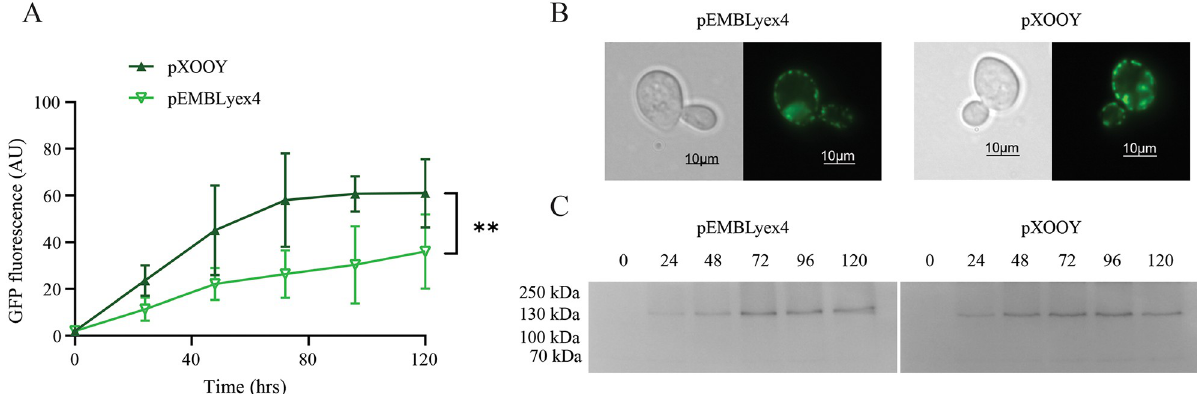
Fig 6. Accumulation of ohSlick-TEV-yEGFP-His 10 in S . cerevisiae . (A) Fluorescence accumulation in 1 OD 450 unit as a function of time after induction of ohSlick-TEV-yEGFP-His 10 production. The bright green curve and the dark green curve show average fluorescence accumulation in PAP1500 cells expressing ohSlick-TEV-yEGFP-His 10 from pEMBLyex4 or pXOOY, respectively. Averages were calculated from four repetitions of the experiment and error bars indicate ± S.D. The accumulation curves were compared using a two-way ANOVA test where �� p = 0.0012. (B) Light microscopy and fluorescence microscopy bio-imaging of yeast cells expressing either ohSlick-TEV-yEGFP-His 10 from pEMBLyex4 (left) or pXOOY (right). (C) In-gel fluorescence of an SDS-PAGE gel of 25 μ g yeast membranes purified from yeast cells harvested at the indicated time points after induction with galactose. The left gel shows purified membrane samples from cells expressing ohSlick-TEV-yEGFP-His 10 from pEMBLyex4 and the right gel shows membrane samples from cells expressing the same fusion protein but from pXOOY. The two gels were imaged with the same exposure time. Uncropped gels can be found in S3, S4